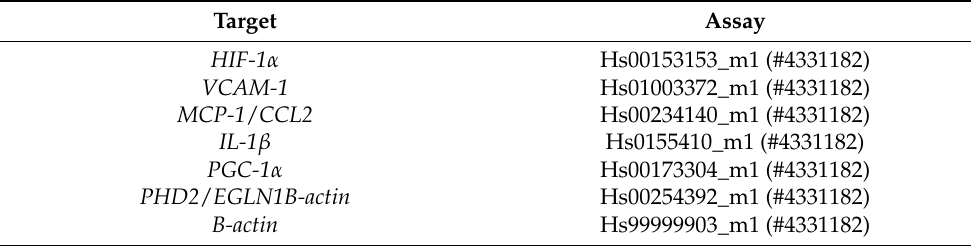
Table 1. TaqMan Gene Expression assays. Target